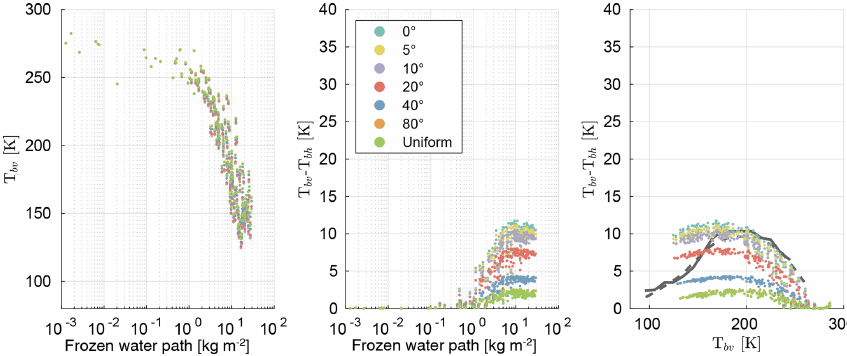
Figure 13. Same as Fig. 12 but for the mass content and the number density of graupel added to